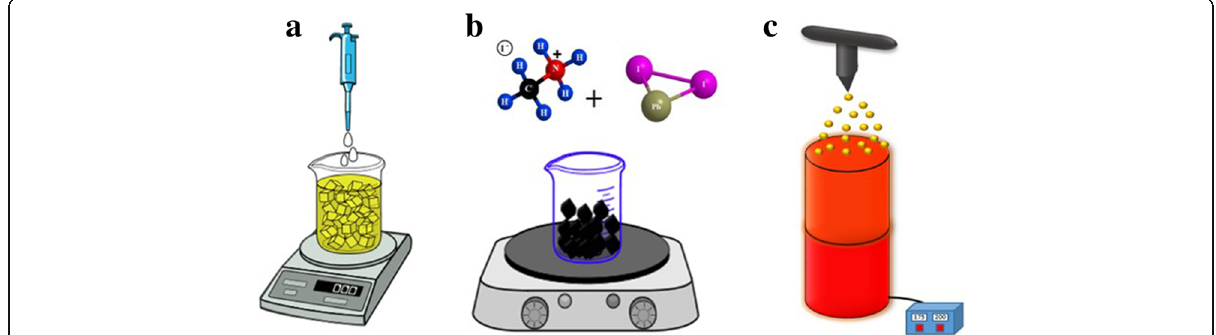
Fig. 1 Three methods of producing perovskite powders used in this work: a wet chemistry anti-solvent method, b dry milling method (on a magnetic stirrer), and c droplet-to particle spray